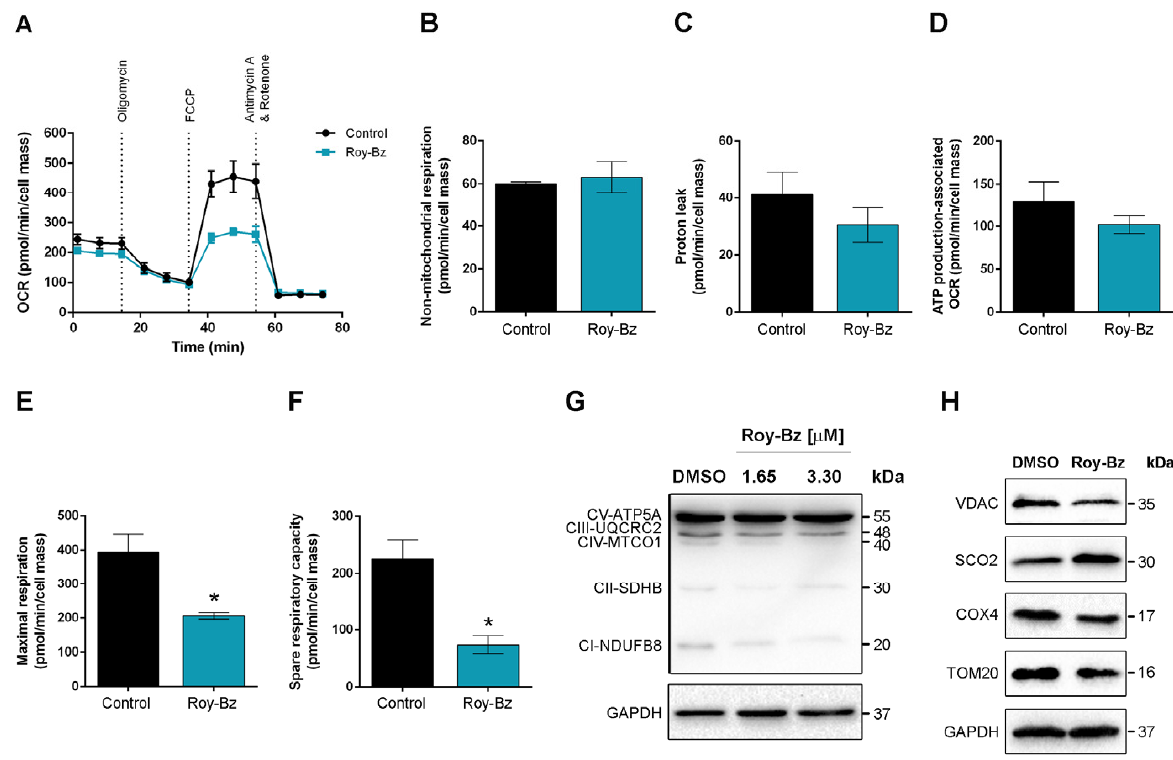
Figure 3. Roy-Bz inhibits cellular respiration in colon cancer cells. HCT116 cells were previously treated with 1.65 μ M Roy-Bz or vehicle (control), except in ( G ) where they were treated with 1.65 and 3.30 μ M Roy-Bz, for 48 h. ( A ) OCR were assessed with a Mito Stress Test using a Seahorse XF96 Analyzer, under basal conditions followed by sequential administration of 1 μ M oligomycin, 0.5